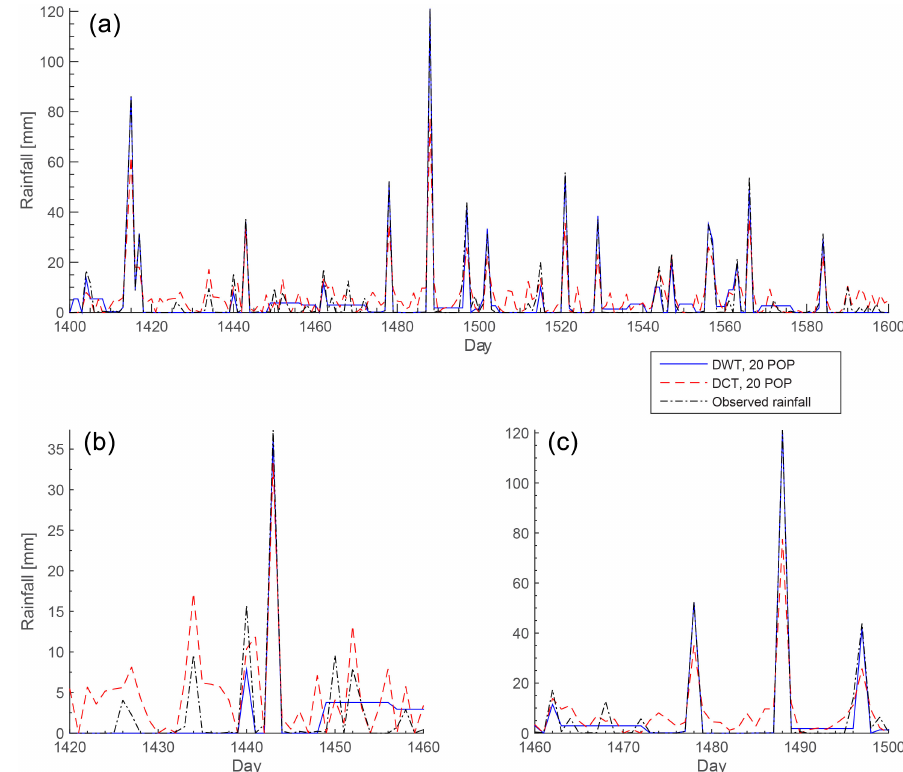
Figure 8. Panel (a) shows a time series comparison of the reconstructed DCT and DWT signals for the Leaf River (Collins) catchment using 20 POP for a period of 200 days. Panels (b) and (c) are smaller windows of the same time series during both low- and high-rainfall